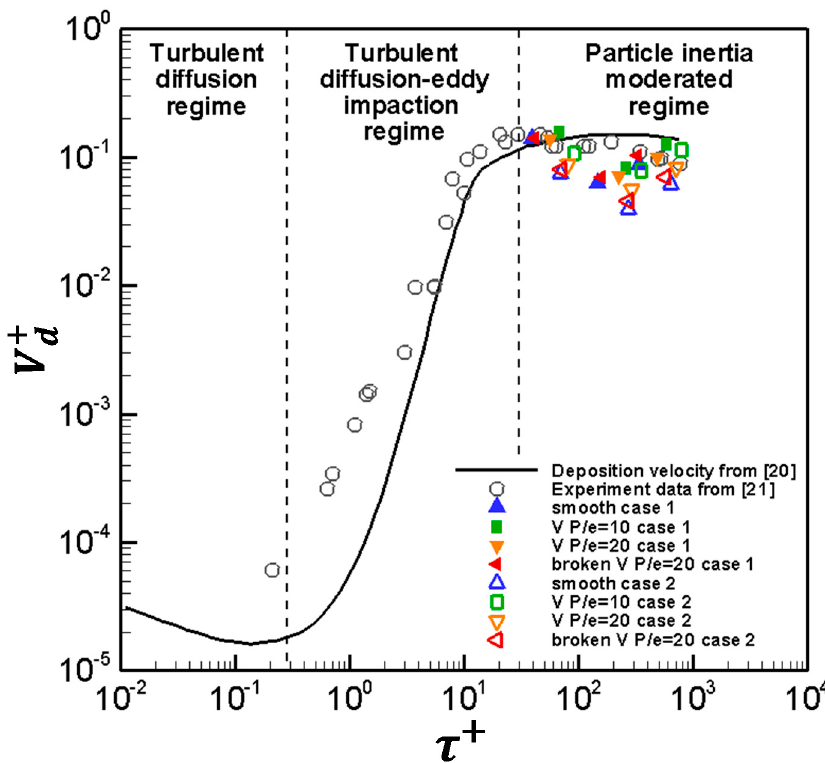
Figure 5. Deposition velocity and relaxation time of the mist flow.